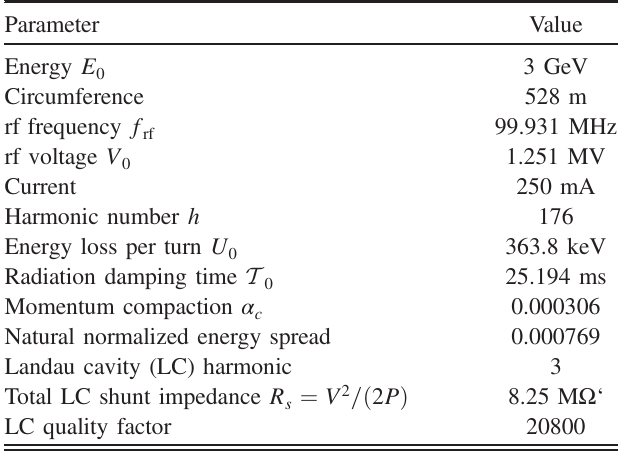
TABLE I. Nominal parameters of the MAX IV 3 GeV ring in delivery including the definition used for the shunt impedance R s where V and P are the voltage and power in the cavity